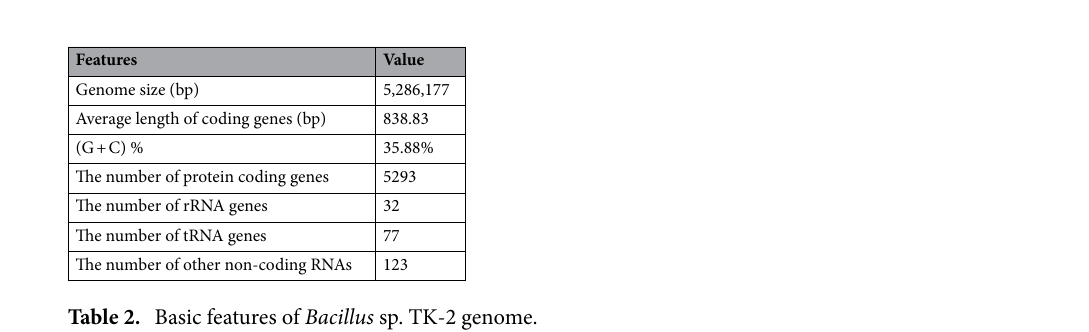
Table 2. Basic features of Bacillus sp. TK-2